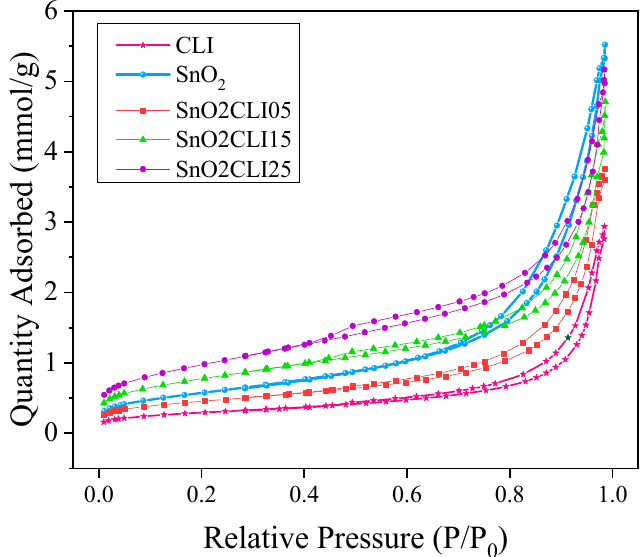
Figure5. Adsorption / desorptionisothermsoftheCLI,SnO 2 , andSnO 2 Figure 5. Adsorption/desorption isotherms of the CLI, SnO 2 , and SnO 2 -containing clinoptilolite samples.